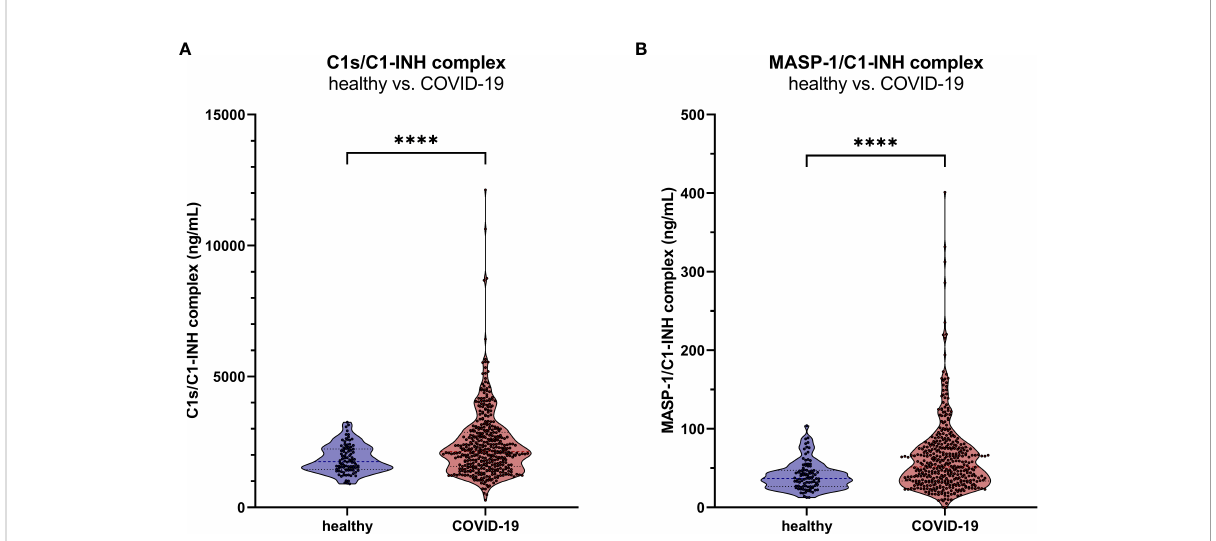
FIGURE 9 C1-INH complex levels in adult COVID-19 patients. The new immunoassays were clinically validated by the measurement of C1s/C1-INH complex (A) and MASP-1/C1-INH complex levels (B) in 414 COVID-19 patients as well as in 96 healthy controls. P values for the pair-wise group comparisons (healthy vs. COVID-19) were calculated by the Mann-Whitney test (****